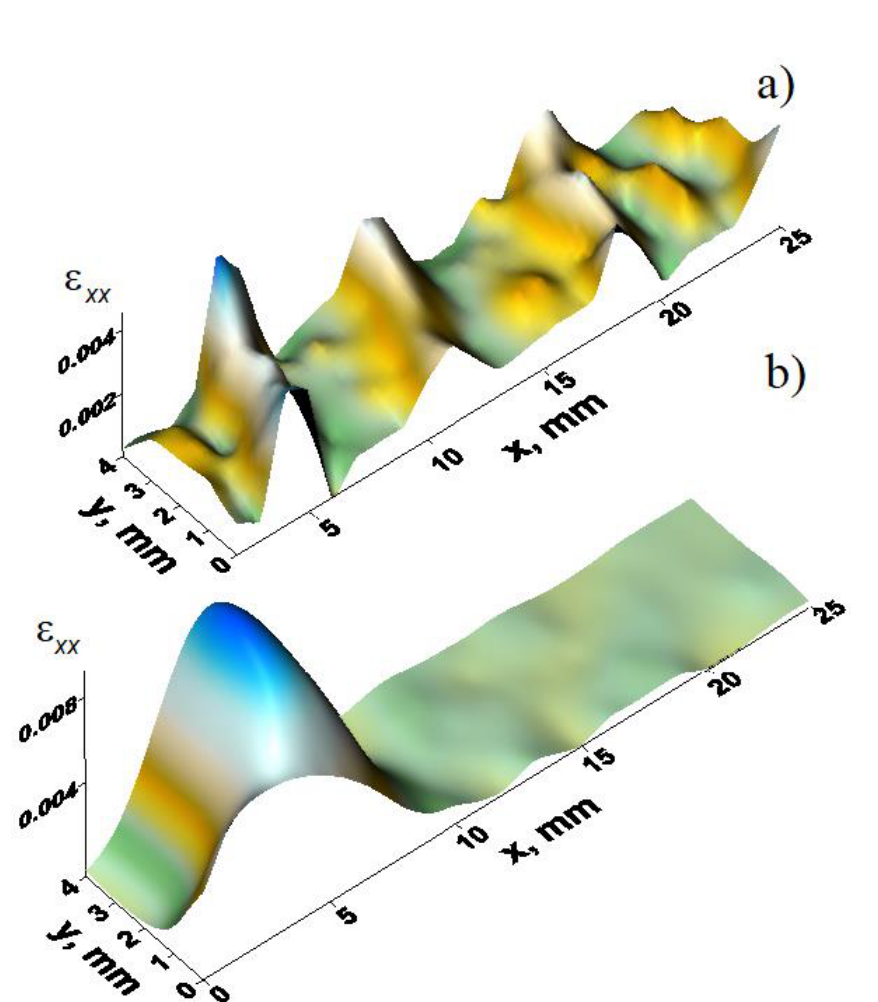
Figure 3. Zones of localized plastic strain distributed across the samples ( a ) No. 1 and ( b ) No. 2. The unfavorable state of the material in sample No. 2 was confirmed by the speed of ultrasound measured along the length of the rolling center (see Curve 1 in Figure 4). It was evident that, upon the transition from the upsetting zone A to the reduction zone B, the ultrasound velocity had a minimum. This meant there was the greatest amount of residual tensile stresses. It has been previously established that there is a linear correlation between the stress σ i and the frequency of autocirculation f of ultrasonic signals proportional to the velocity of ultrasound propagation ( f ∼ V S ), and the regression line equation has the following form [32]: where σ 0 = 420 MPa, α = 0.42 MPa · s, and the coefficient of correlation between σ i and f parameters is ~0.72, being statistically significant. The data were acquired during a series of experiments conducted on pilgerheads of Zr–1.0% Nb